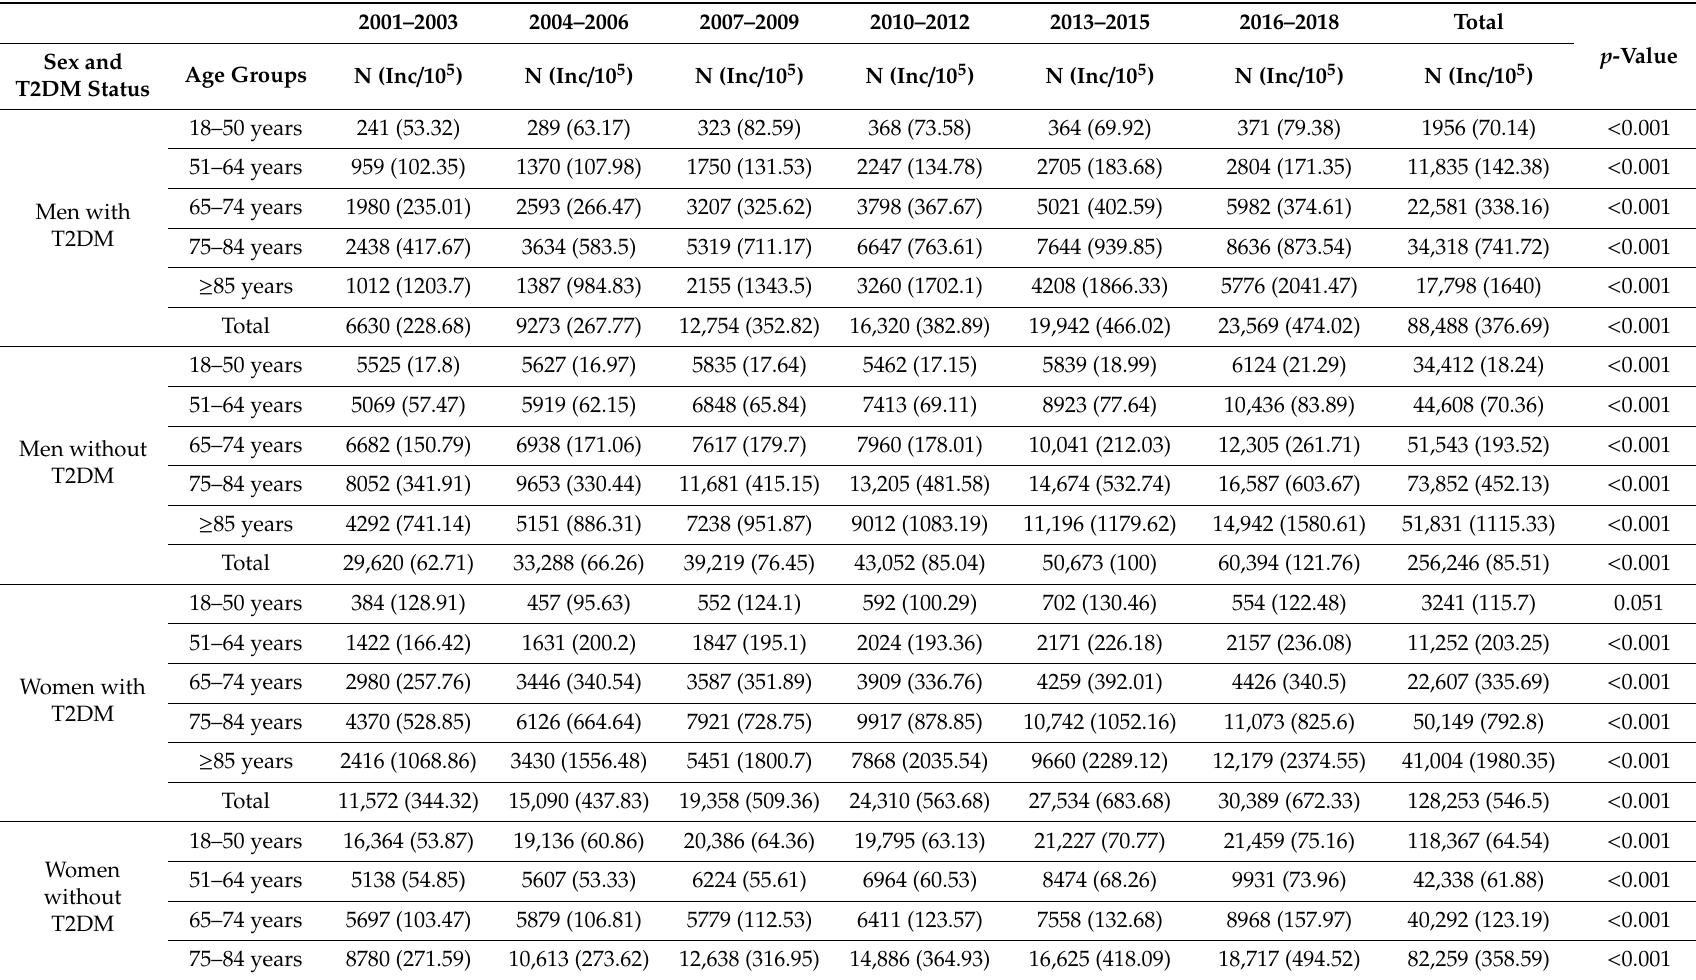
Table 1. Hospital admissions among patients with a principal diagnosis of urinary tract infection per 100,000 inhabitants in Spain from 2001 to 2018, according to diabetes status, age groups, and